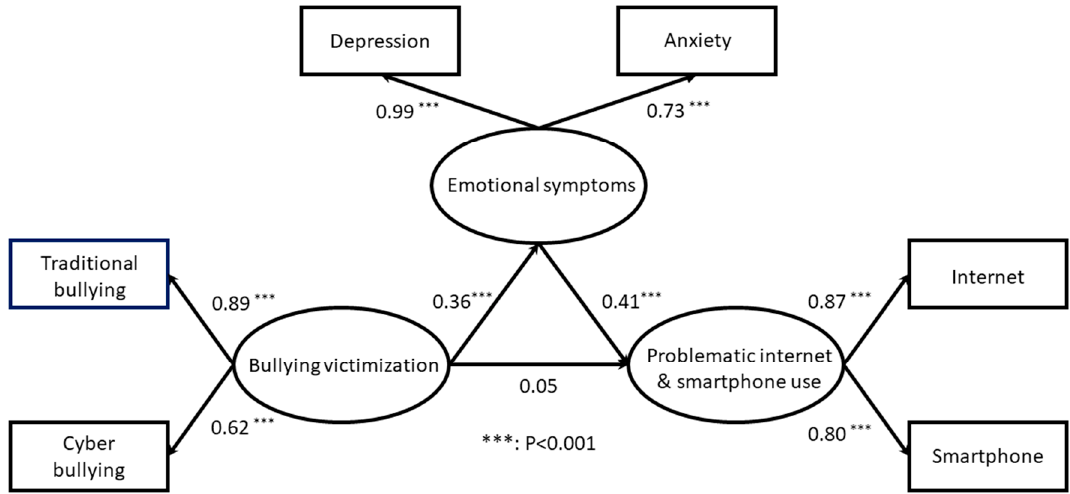
Figure 2. Final model of mediating effect indicating the estimated coefficients of the paths and factorial loadings. Table 2. The indices of goodness-of-fit index for the mediation model.